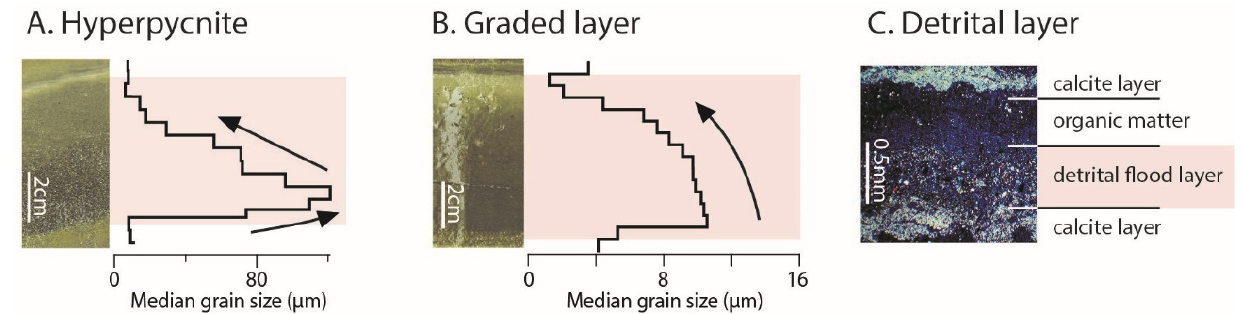
Figure 3. Examples of the most classical types of flood layers with a photo and the evolution of grain size: ( A ) hyperpycnite, ( B ) graded layer and ( C ) detrital layer. The hyperpycnite and the graded layer were observed in the sediment sequences of the northern and southern basins of Lake Allos (France), where they result from hyperpycnal and homopycnal currents respectively [24]. Black arrows highlight the coarsening and/or the fining-upward trends typical of these deposits. The detrital layer has been observed in the sediment sequence of Lake Montcortès (Spain) with a thin section under microscope. This reveals that the detrital flood layer is intercalated within a seasonal cycle of calcite (summer/early autumn) and organic (winter/spring) layers